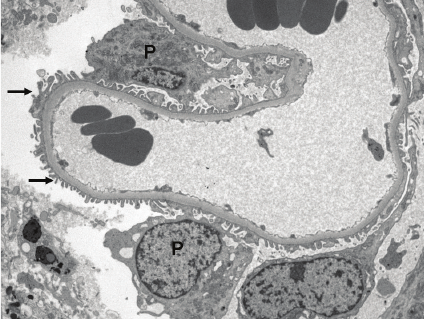
Figure3:Electronmicroscopyshowinglackofpodocyteeffacement or glomerular basement membrane changes. Arrows: intact foot processes, P: podocytes (original mag. =